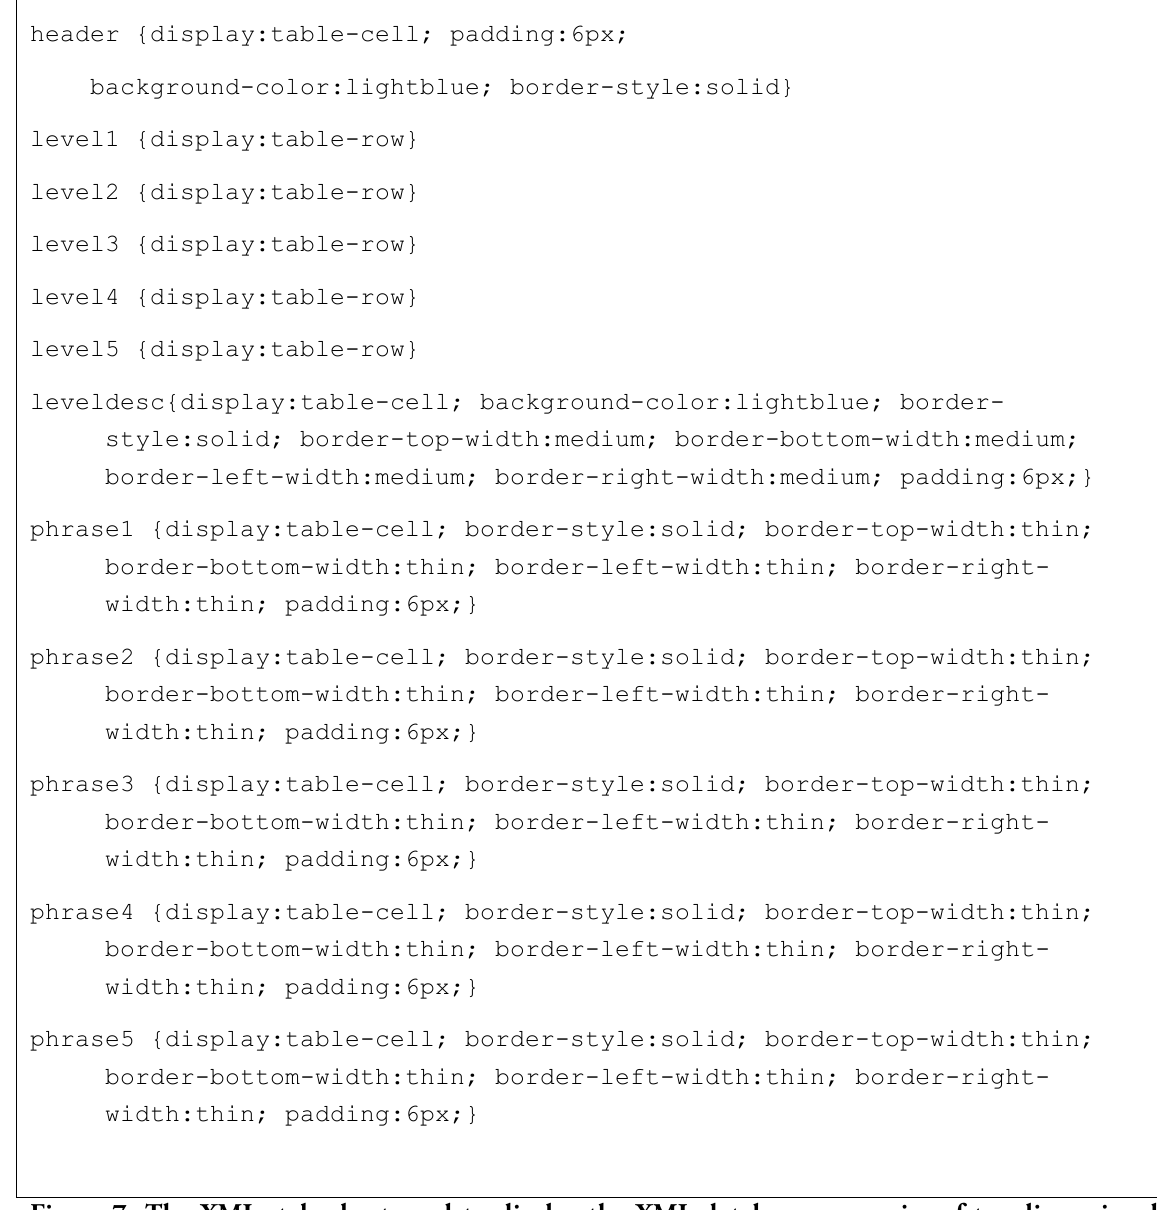
Figure 7. The XML style sheet used to display the XML database as a series of twodimensional tables in the Firefox or Opera web